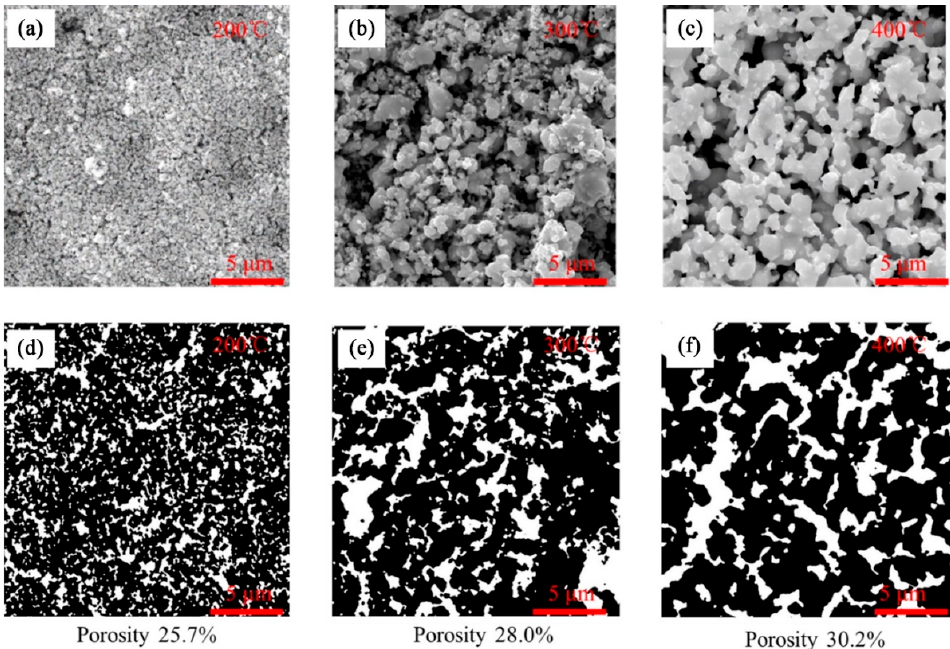
Figure 3. Sintered Ag powder: ( a ) 200 °C , ( b ) 300 °C , ( c ) 400 °C ; ( d – f ) are images of ( a – c ) processed using Photoshop CS6, respectively.